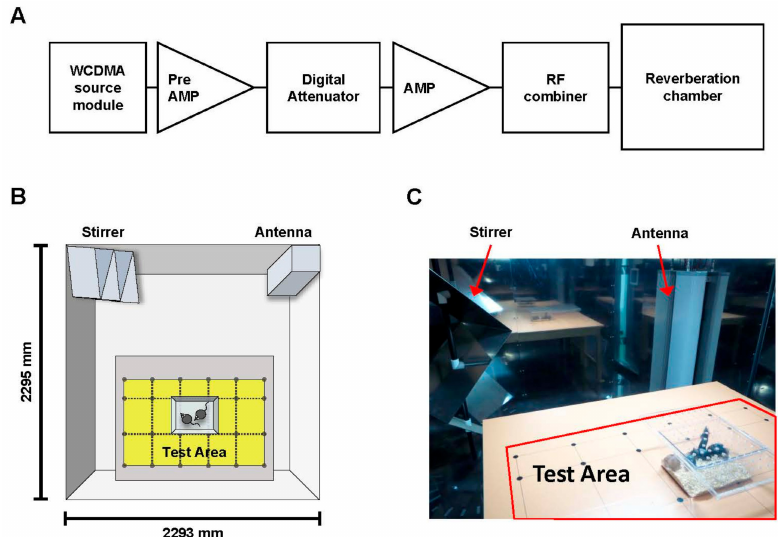
Figure 7. RF-EMF exposure system. ( A ) Schematic flow chart of RF-EMF signal transduction into the reverberation chamber; ( B ) Diagram of RF-EMF exposure test area in the reverberation chamber; ( C ) Photograph of the inner structure of the reverberation